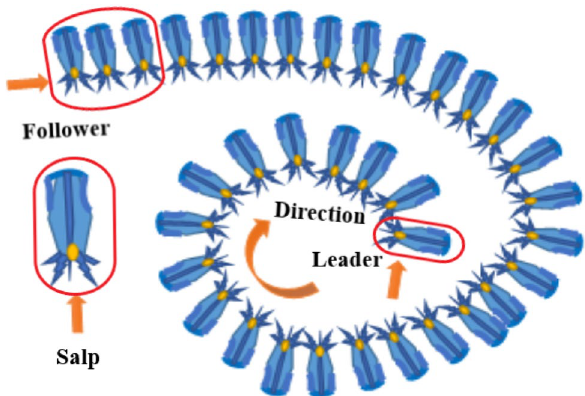
Figure 6. Structure of salp